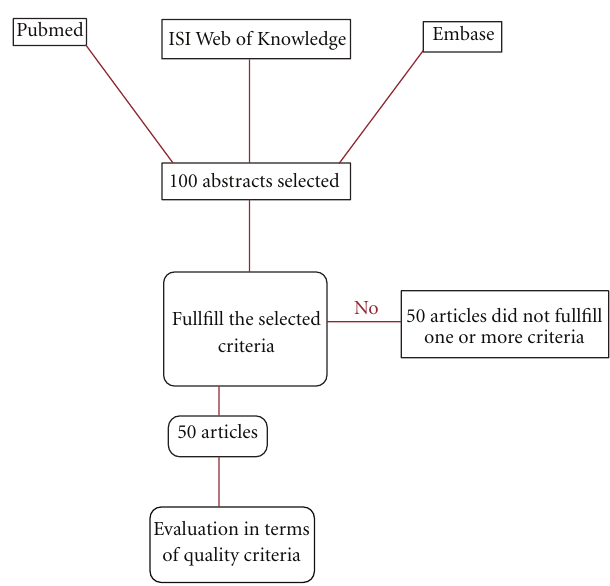
Figure 2: Results of review